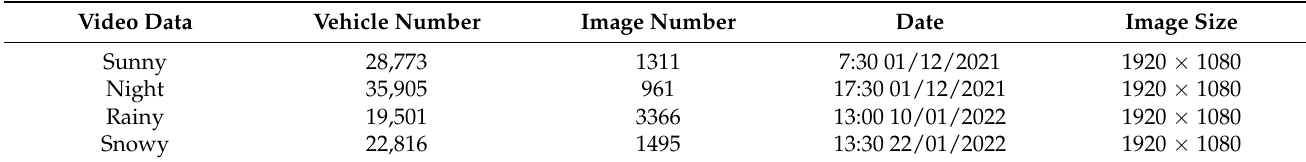
Table 4. Details of the MWVD dataset used in the experiment.